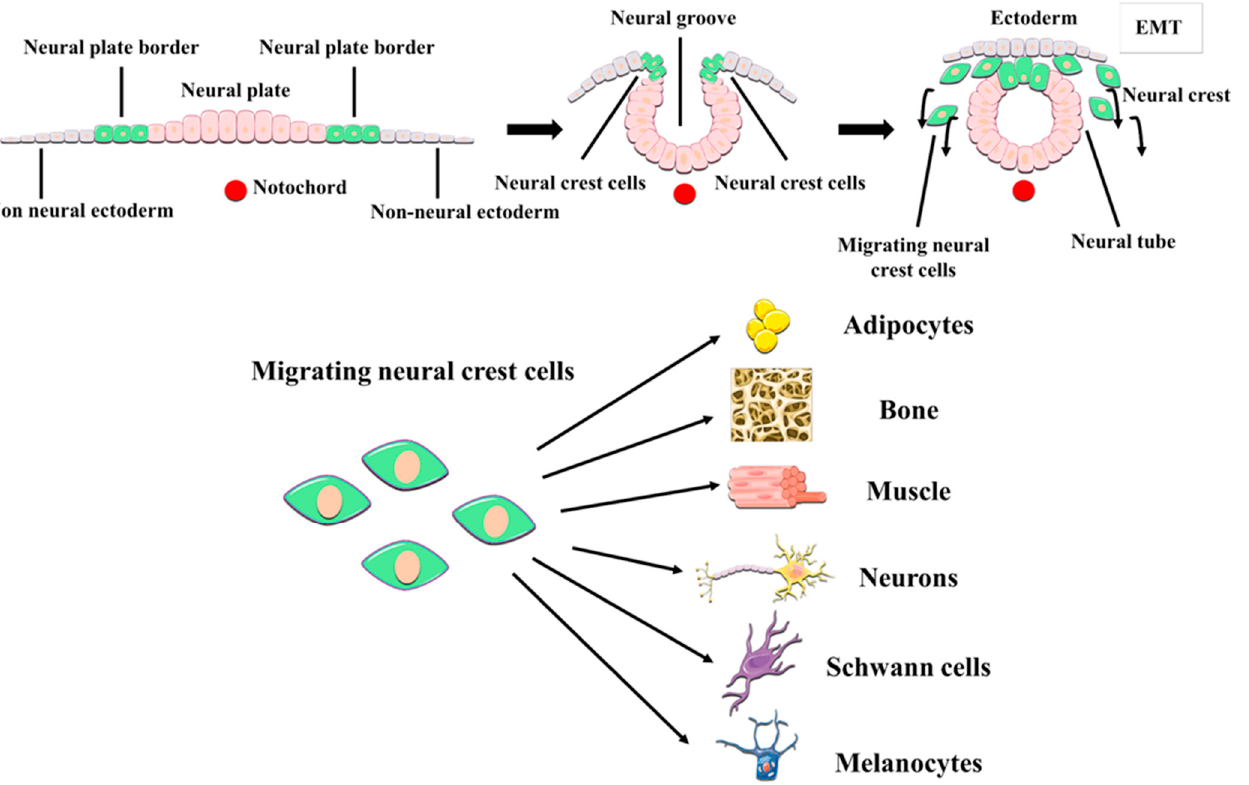
Figure 1. Embryonic origin and multilineage differentiation of human dental pulp stem cells (hDPSCs). hDPSCs derive from neural crest stem cells that generate craniomaxillofacial tissues, including the dental pulp. During development, neural crest cells undergo an epithelial-mesenchymal transition (EMT) and migrate out of the neural tube, to give rise to both mesenchymal and non-mesenchymal cell lineages of the oral cavity, like the neurons and glial cells of the craniofacial PNS. hDPSCs show many neural crest characteristics such as their expression of neural crest markers, and a higher differentiation potential to neural cell lineages than other MSCs.